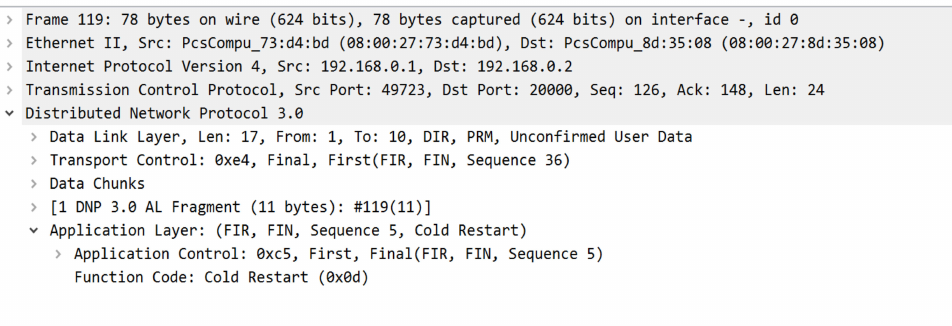
Figure 5. An example of DNP3/TCP packets captured using Wireshark.